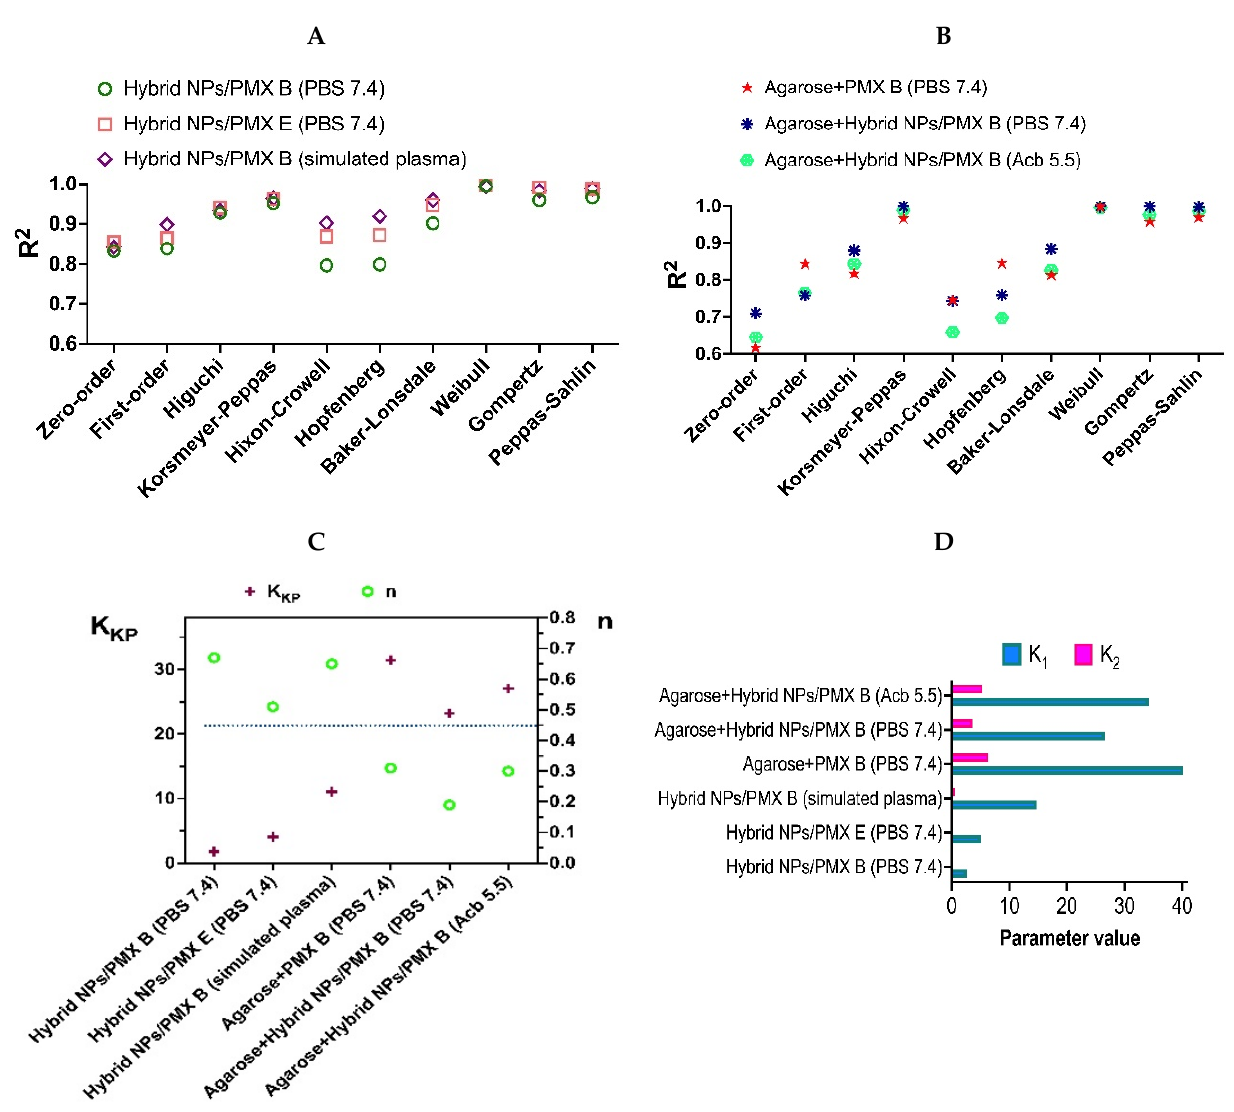
Figure 11. Results of mathematical analysis of PMX release profiles with application of standard models: ( A ) comparison of correlation coefficients of the regressions obtained with different models for release from hybrid NPs; ( B ) comparison of correlation coefficients of the regressions obtained with different models for release from agarose gel and composite gels; ( C ) results obtained by application of the Korsmeyer–Peppas model, K KP —release rate constant from the Korsmeyer–Peppas equation, n —parameter from Korsmeyer–Peppas equation showing the mechanism of drug release; ( D ) results obtained by application of Korsmeyer–Peppas model, K 1 —impact of diffusional mechanism, K 2 —impact of relaxation on release.